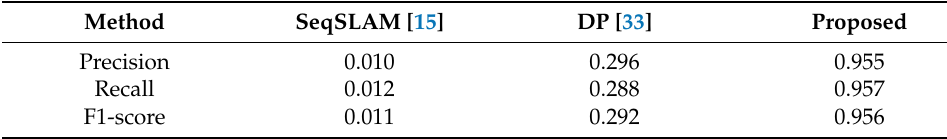
Table 2. The precision–recall and F1-score